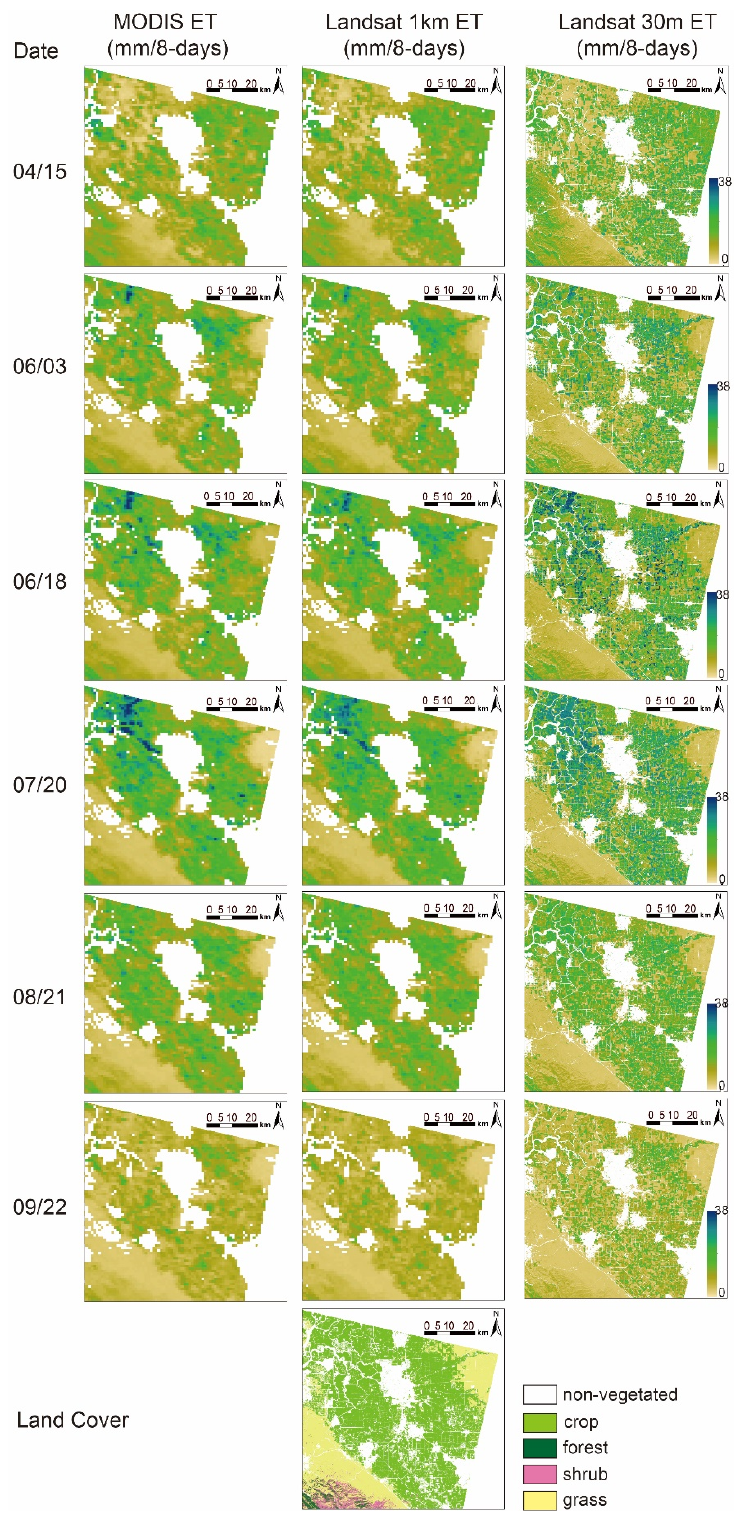
Figure 7. MODIS 8-day ET, Landsat 1 km ET and downscaled Landsat 30 m ET in the northeast part of Site 2 (refer to Figure 2b blue outline for the area boundary) during the year of 2013.